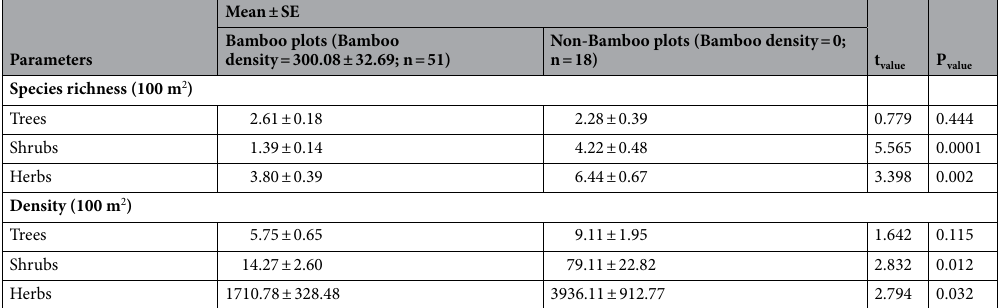
Table 2. Species richness and density of trees, shrubs and herbs between bamboo and non-bamboo plots. Mean values ± SE of the vegetation parameters calculated and compared between bamboo and non-bamboo plots using t-test for independence samples assuming unequal variance.